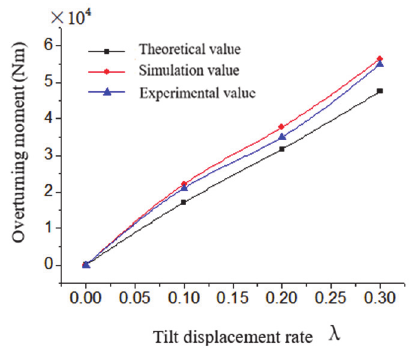
Figure 9. Relationship between overturning moment and tilt displacement rate.